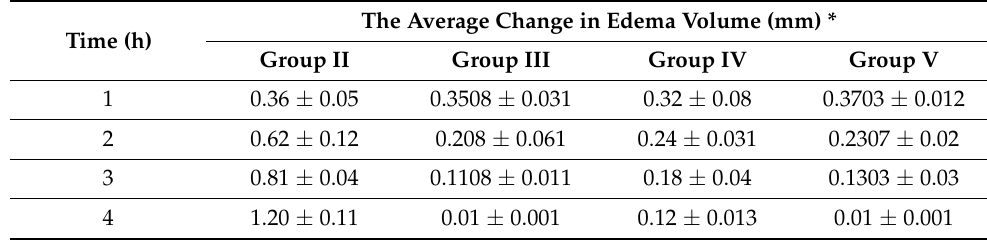
Table 3. The average change in the edema volume at different time intervals over 4